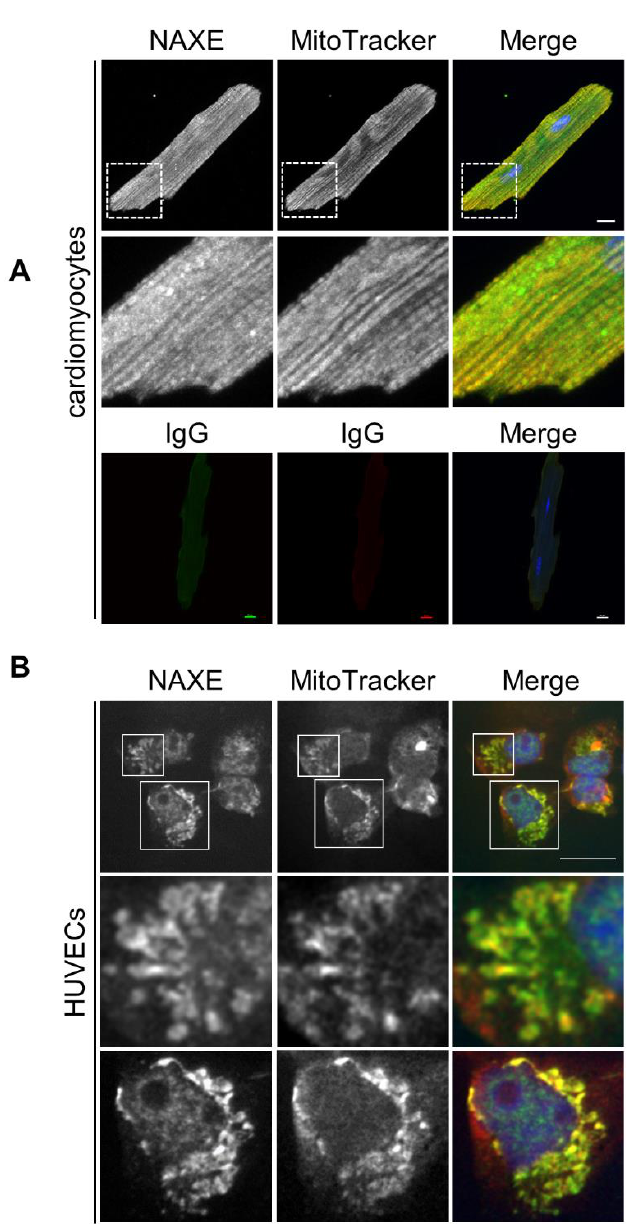
Figure 9. Subcellular localization of NAXE. ( A ) Cardiomyocytes were fixed and stained with our homemade NAXE Abs (green) or with control secondary antibody alone. DAPI staining (blue) was employed to visualize the cell nuclei, and the images were captured using a Leica fluorescence microscope. ( B ) HUVECs were incubated with 25 µM MitoTracker Deep Red for 1 h; then, they were fixed and immunostained with NAXE Abs (green). The enlarged images traced by the white lines are shown below. Note that vesicle-like NAXE staining is found inside the cytosol. Scale Bar: 25 µm.